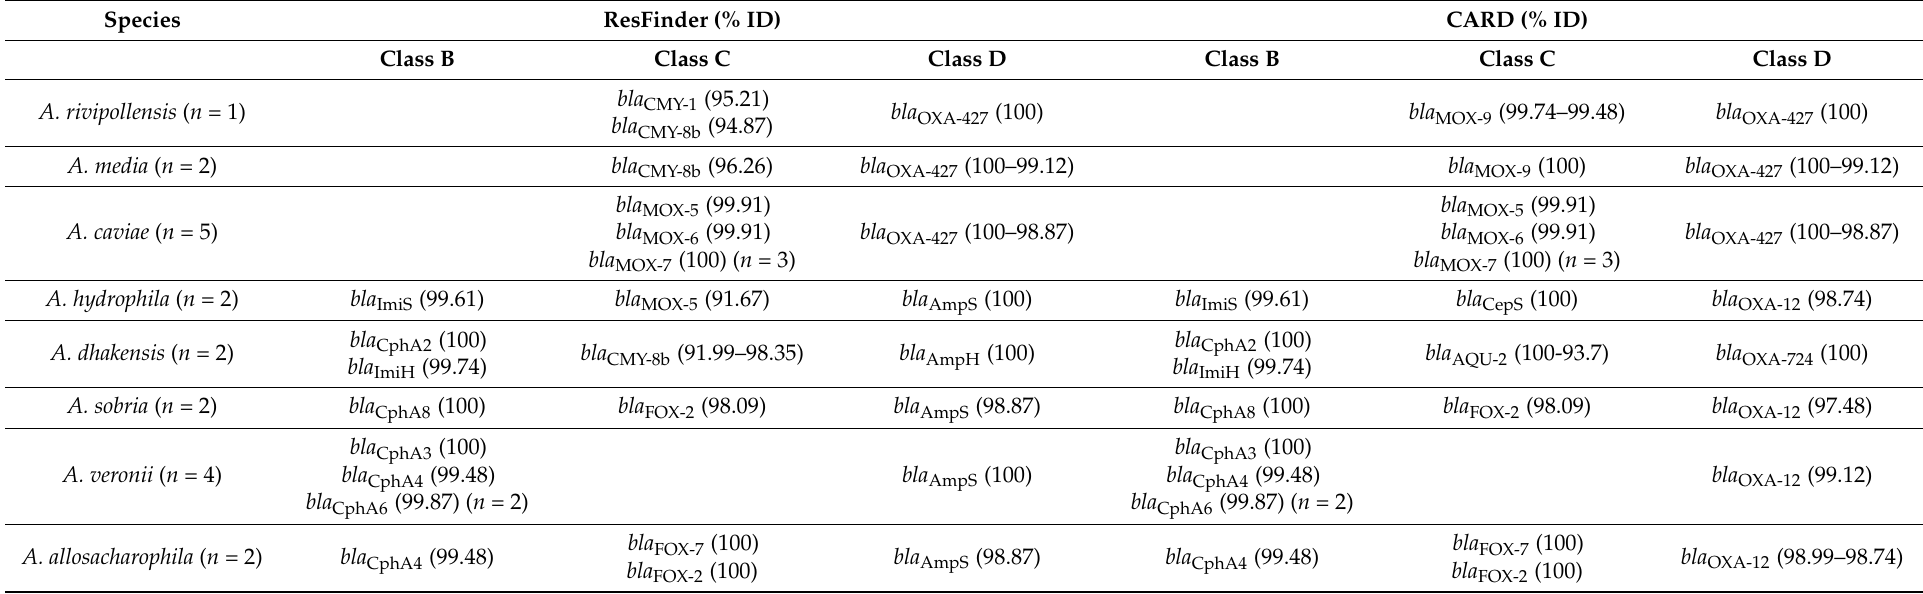
Table 3. Comparison of ResFinder and CARD databases to screen for β -lactamase